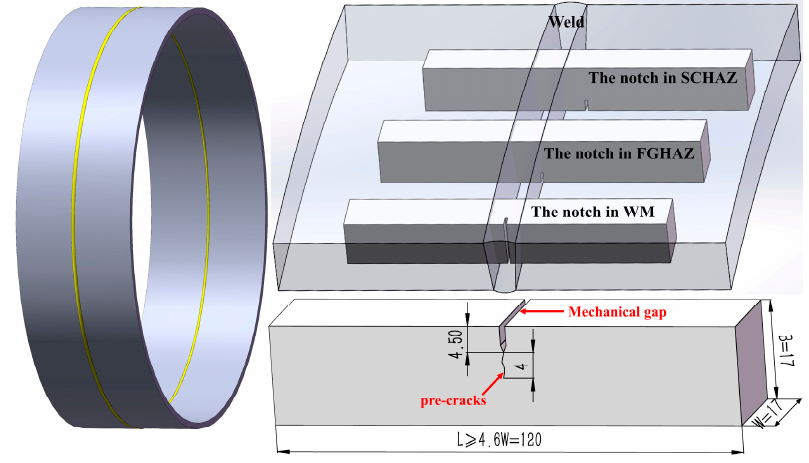
Figure 2. The locations of CTOD samples.